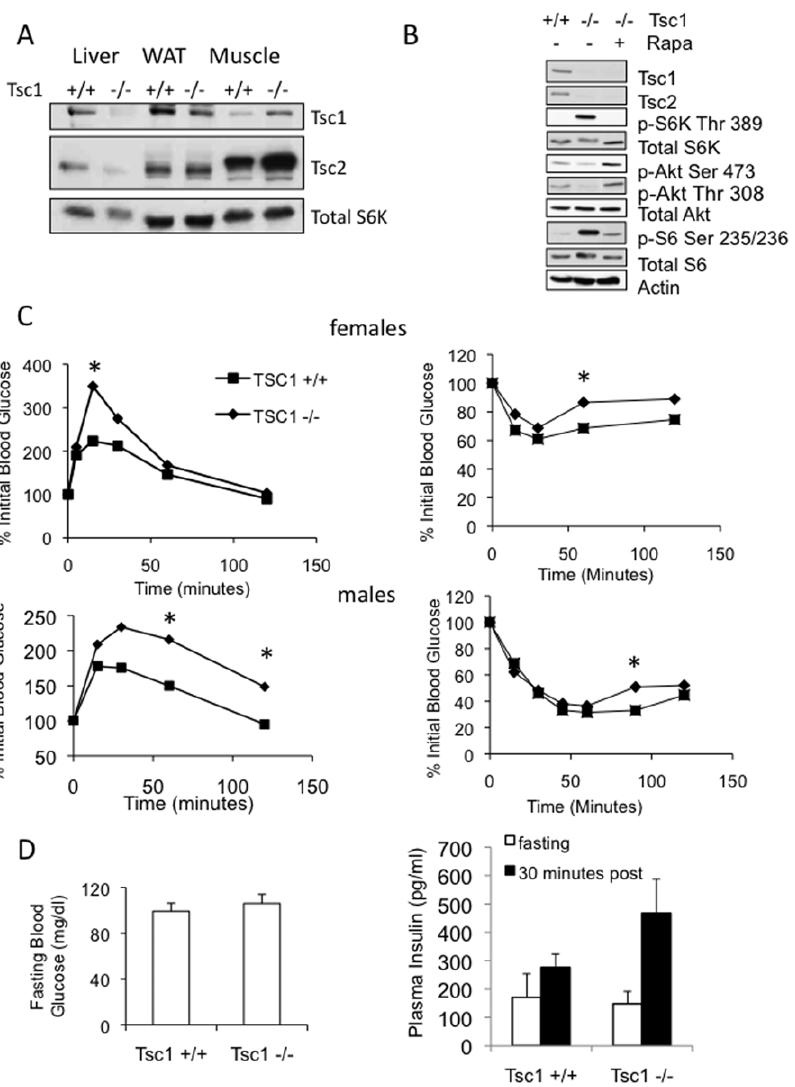
Figure 1. Hepatocyte-specific deletion of Tsc1 leads to mild insulin resistance. A. Liver-specific ablation of Tsc1 . Tsc1 fl/fl mice were crossed to Cre Alb mice resulting in Tsc1 fl/fl ; Cre + / + (a.k.a. Tsc1 + / + ) and Tsc1 fl/fl ; Cre Alb (a.k.a. Tsc1 2 / 2 ) littermates. Tissues from eight-week old Tsc1 2 / 2 and Tsc1 + / + animals were analyzed for the expression of Tsc1, Tsc2 and S6K by immunoblot analyses using the indicated antibodies. WAT, white adipose tissues. Note the reduced Tsc2 expression secondary to its diminished stability in the absence of Tsc1 [30]. B. The loss of Tsc1 in hepatocytes resulted in increased mTORC1 activity (based on the expression of phospho-S6K and phospho-S6) that was sensitive to rapamycin. Tsc1 2 / 2 mice were fasted and treated with or without rapamycin (2 mg/kg IP, 6 hrs). Liver lysates were analyzed by SDS-PAGE and blotted with the indicated antibodies. Note the effect of rapamycin on Akt phosphorylation in the Tsc1 2 / 2 liver. Actin, loading control. C. Systemic glucose tolerance (left) and insulin sensitivity (right) tests in 8-week old female (top) and male (bottom) mice. Following a 16-hr fast, glucose (1 mg/g) was given IP followed by serial blood glucose monitoring at indicated times. For insulin sensitivity test, 0.5 mU/g of insulin was injected IP after a 4-hr fast. *, p , 0.05 between the Tsc1 + / + and Tsc1 2 / 2 groups. D. Fasting blood glucose and insulin levels in wild-type and mutant mice. Plasma insulin levels 30 minutes after glucose administration are also shown (filled boxes).